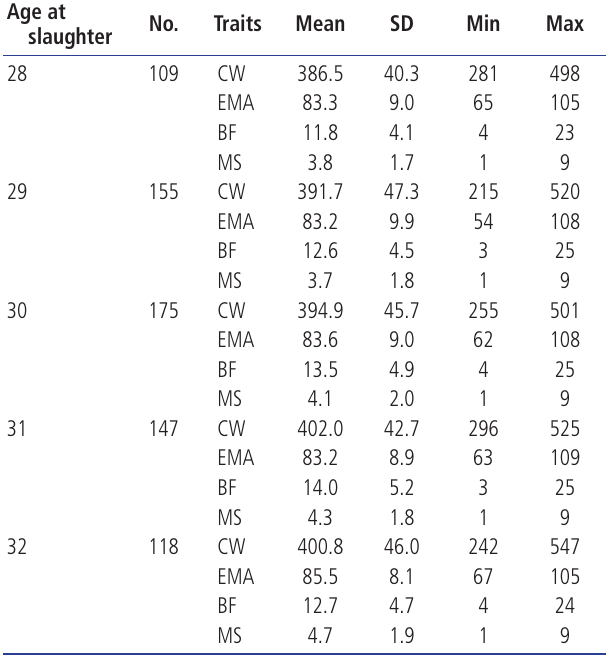
Table 7. Basic statistics of castrated animals by age at slaughter (months) Age at No. slaughter